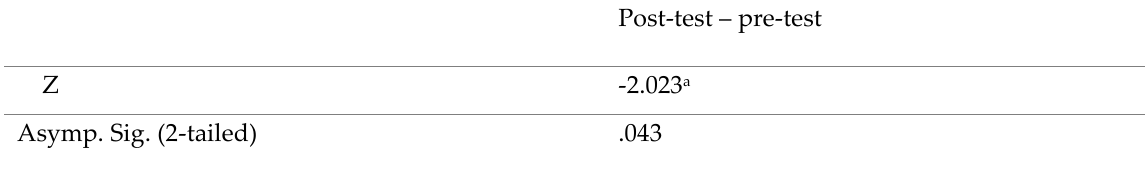
Tabel 2. Result of Wilcoxon Signed-Rank Test on career